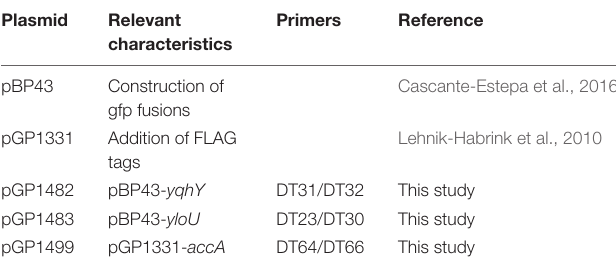
TABLE 2 | Plasmids used in this